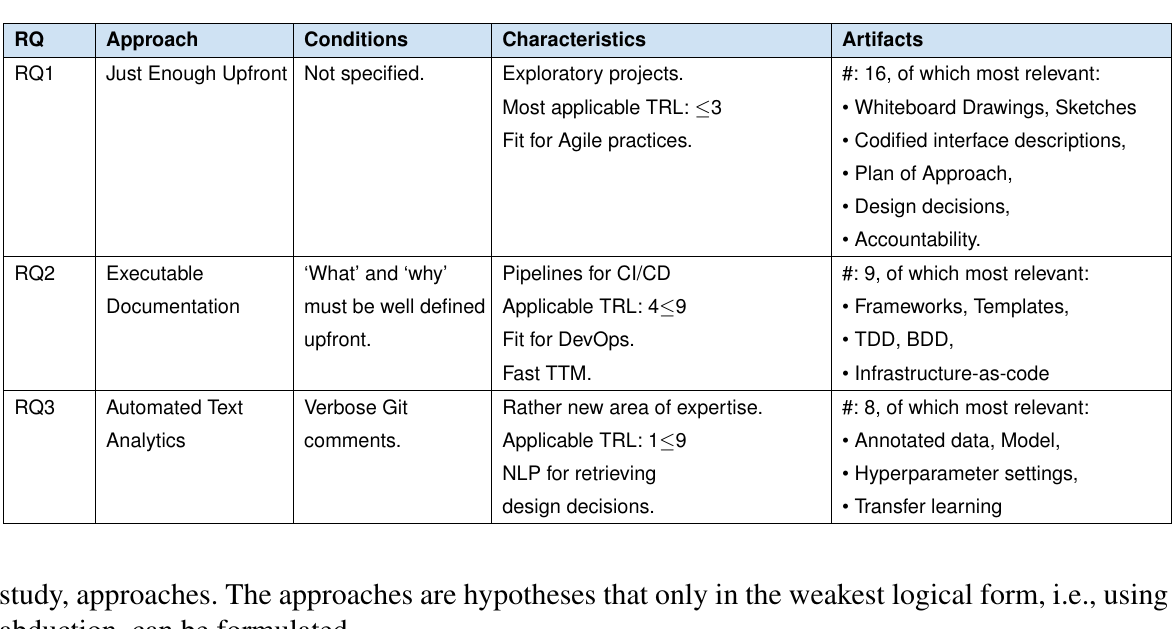
Table 7. Answers to Research